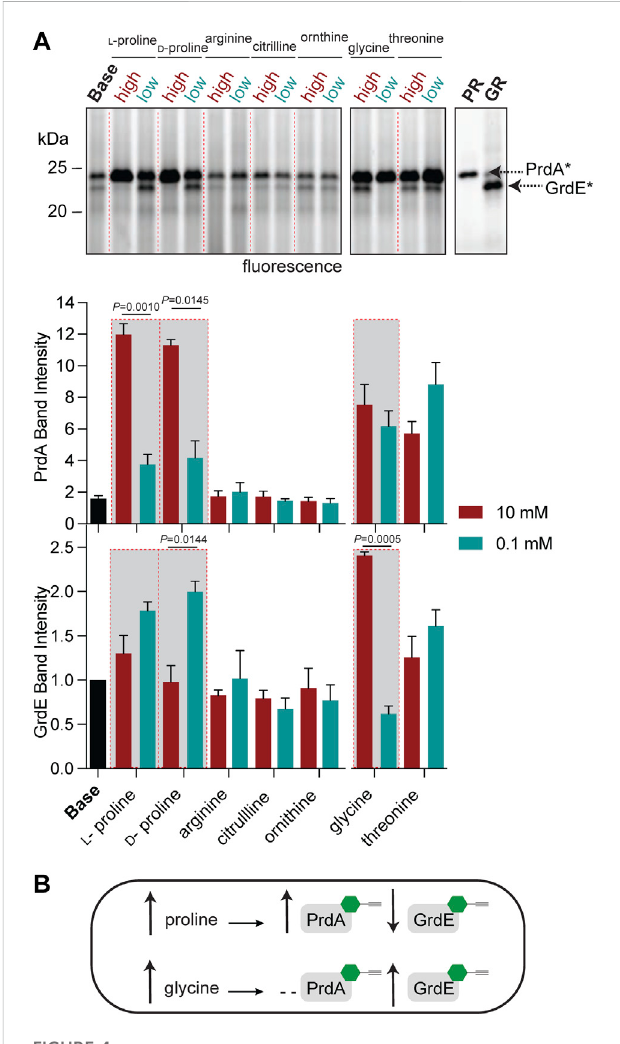
FIGURE 4 Functional pro fi ling of the Pvyl cofactors of PrdA and GrdE by hydrazine probes. (A) , Gel-based monitoring of the fraction of Pvyl-PR and Pvyl-GR labelled by 2 inMM (Base)supplemented with high (10 mM) and low (0.1 mM) concentrations of selected metabolites ( upper ). 2 -Labelled puri fi ed PR and 2 -treated lysate of glycine-grown cells are included as controls. The normalized relative band intensities of Pvyl-PR and Pvyl-GR in the various media conditions normalized to expression, with Pvyl-GR in Base set to relative intensity of 1, are shown below (mean ± SEM, n = 3, t -tests with Welch ’ s correction using Prism9, p < 0.05issigni fi cant).SeeSupplementaryFigureS19forfulllabellinggeland corresponding expression pro fi les. (B) , Schematic demonstrating the effects of proline and glycine on the fraction of Pvyl-PR and Pvyl-GR, emphasized in red-outlined boxes in (A)